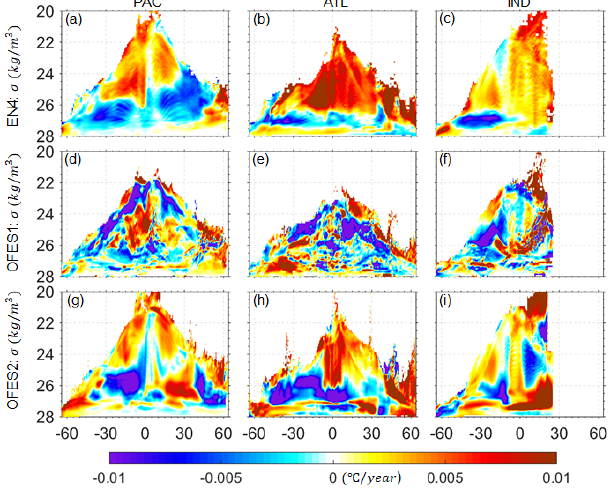
Figure 18. Linear trends in the zonal-averaged warming or cool- ing along the neutral density surfaces in the Pacific (a, d, g) , At- lantic (b, e, h) , and Indian (c, f, i) oceans. Top to bottom: EN4, OFES1,